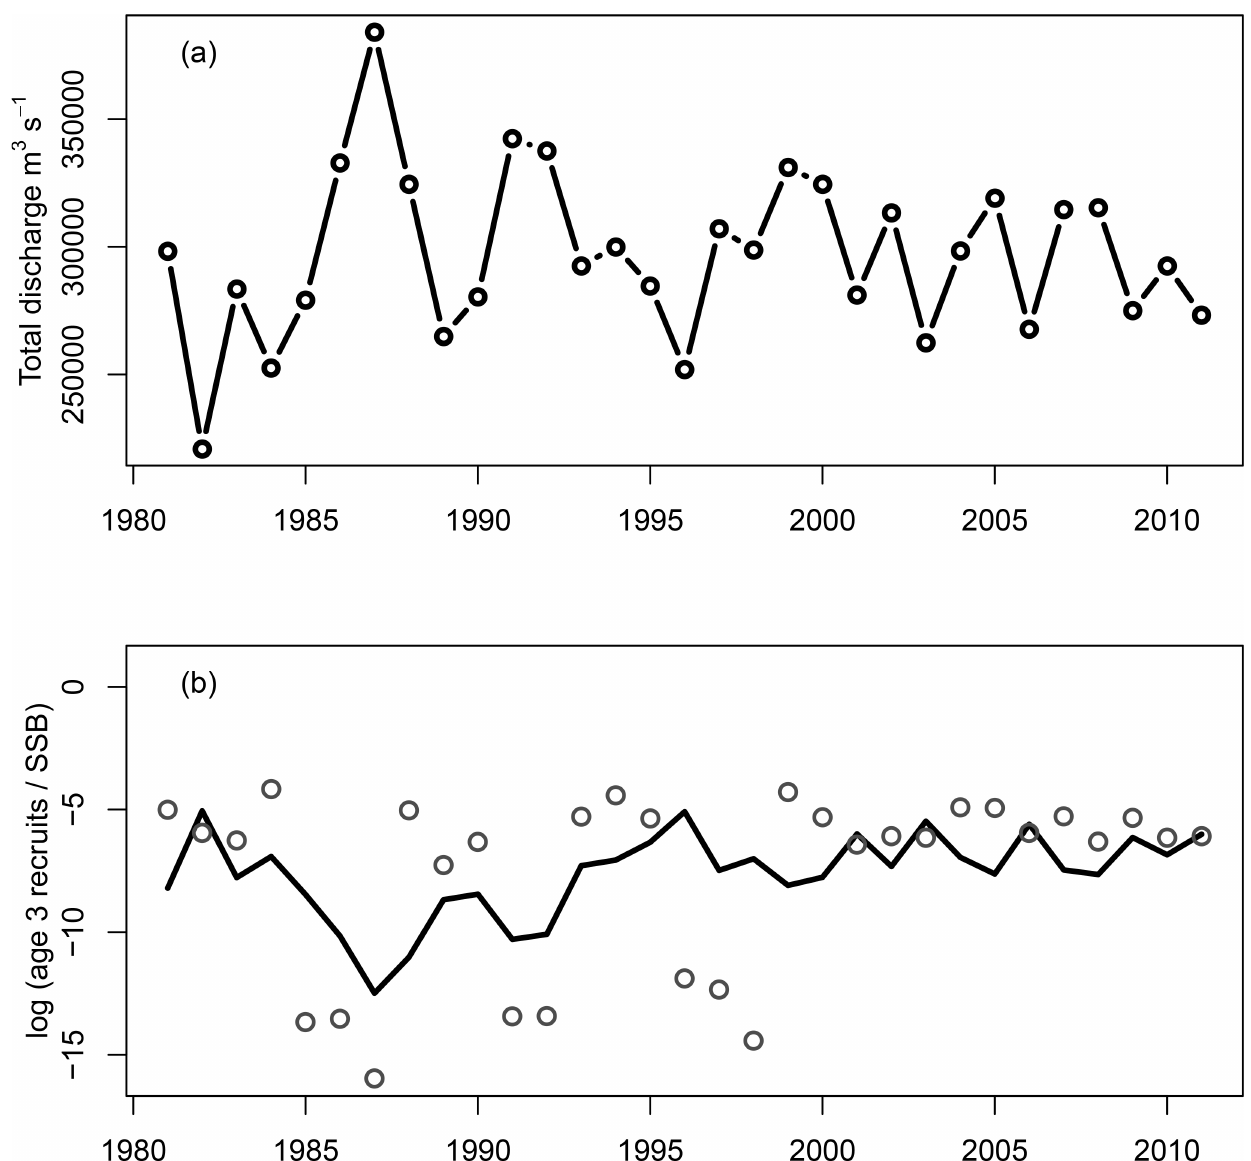
Fig 6. Gulf of Alaska freshwater discharge (Royer 1982, IMS 2016) as a driver of Pacific herring productivity. Shown are (a) the total freshwater discharge (m 3 s-1) and (b) log of observed age-3 recruits per spawning biomass (mt)—log(recruits/SSB)—in grey circles, and the model predicted log (recruits/SSB) using freshwater discharge as a covariate (R 2 = 0.55). High discharge events correspond to reduced productivity (fewer recruits to the population as three year olds). For historical reference, the discharge time series starting in 1931 is shown in S2 Fig. R = millions of mature and immature age-3 herring, SSB = spawning stock biomass in metric